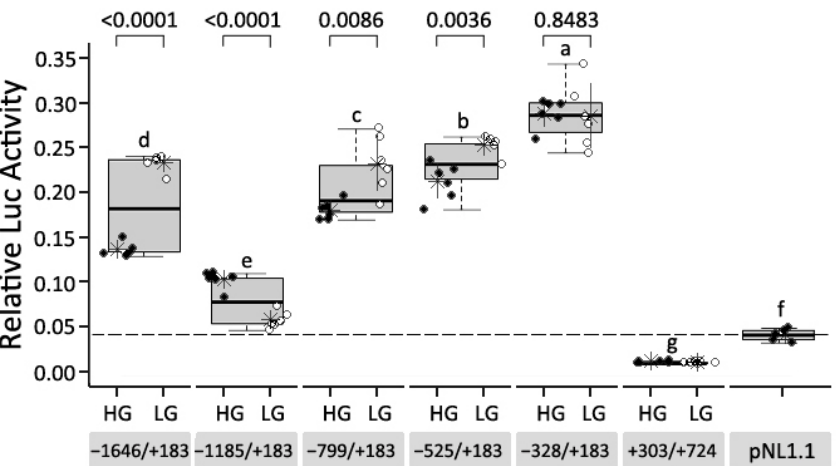
Figure 3. Identification of the core promoter of chicken CCKAR and regulatory effect analysis of sequence variants. The boxplots indicate the distribution of data from each construct. The letters on the boxplots indicate the results of multiple comparison among constructs. Different letters represent that there is significant difference ( p < 0.05) between two constructs. Numbers at the top of each boxplot are p -values of significance tests for differences between haplotypes. An asterisk represents the mean of data from each haplotype, and the short lines on both sides of each asterisk represent SD. The dashed line represents background signal produced by empty pNL1.1. HG = high-growth haplotype, LG = low-growth haplotype.